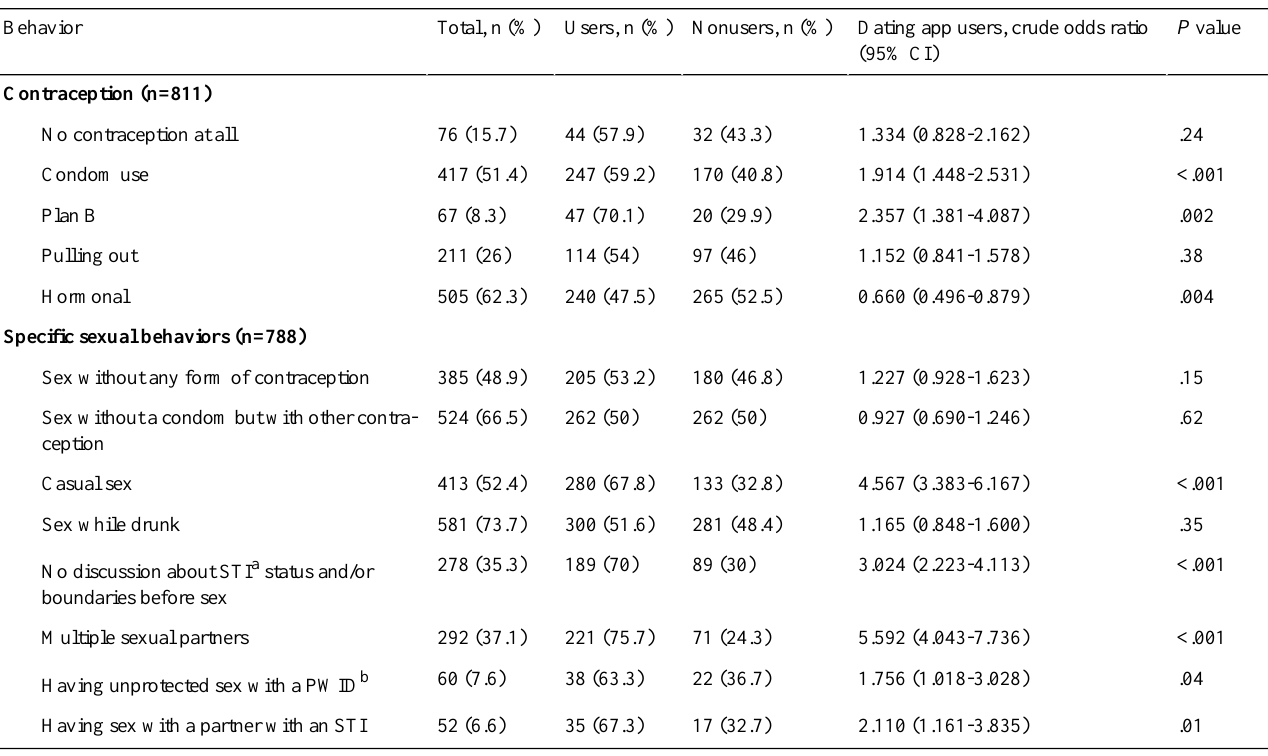
Table 2. Logistic regression of geosocial networking dating app users and sexual behaviors.